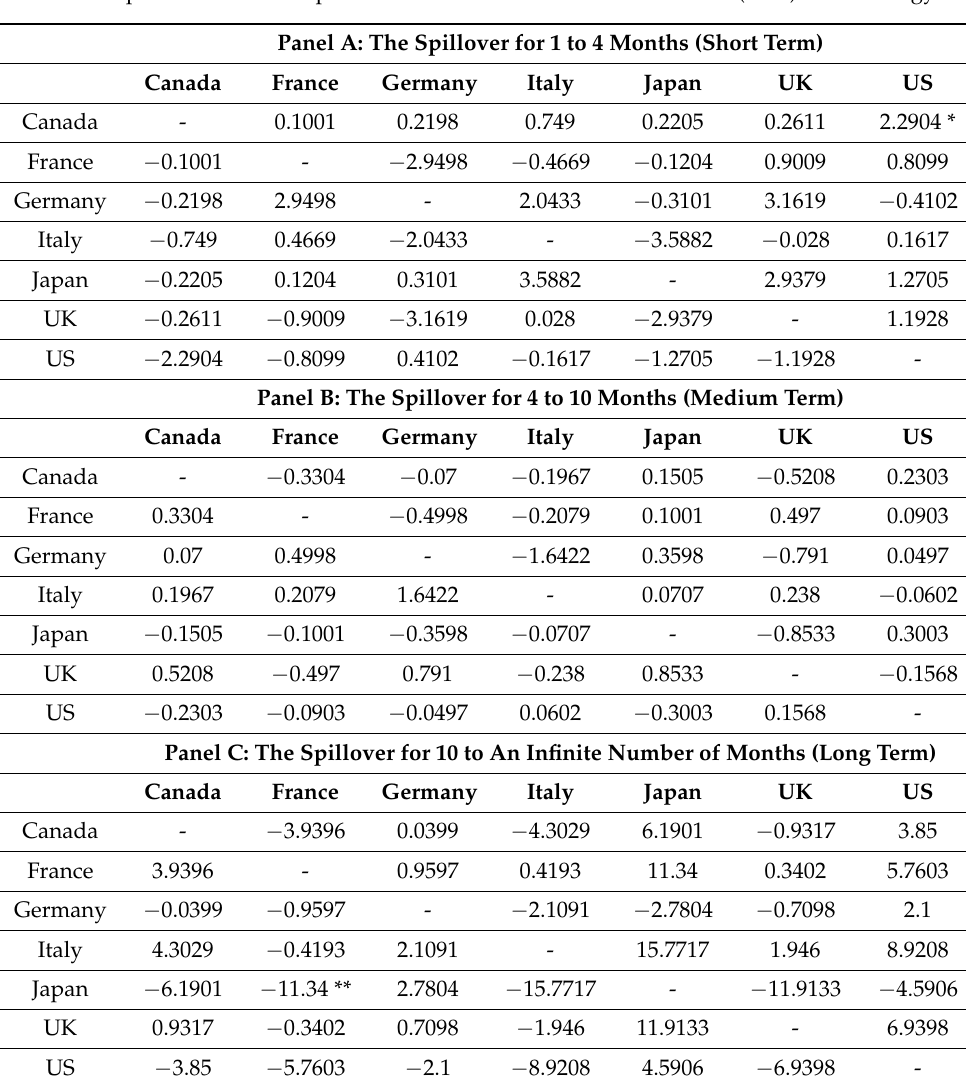
Table 5. Net pairwise inflation spillover based on the Barunik and Krehlik (2018) methodology. Panel A: The Spillover for 1 to 4 Months (Short Term)